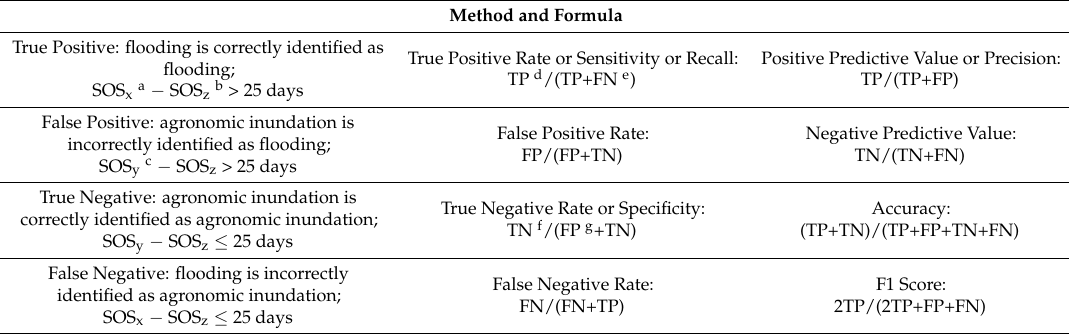
Table 3. Evaluation matrix to assess estimated flooded rice pixels derived using EVI40. Method and